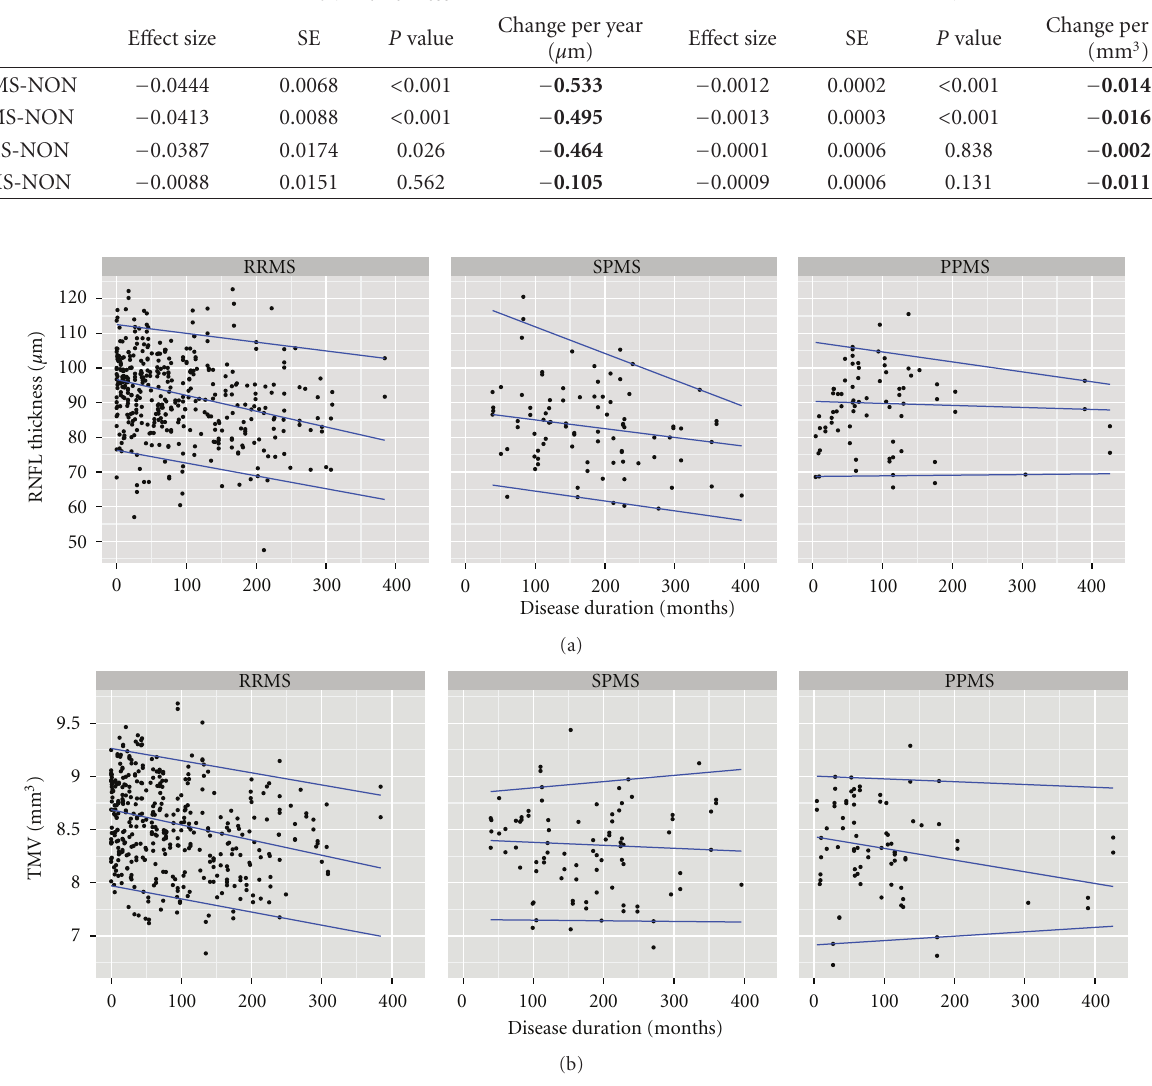
Figure 3: Association of RNFL thickness (a) and TMV (b) with disease duration for RRMS, SPMS and PPMS subtypes in eyes without previous optic neuritis. The blue lines indicate the 95%-, 50%- and